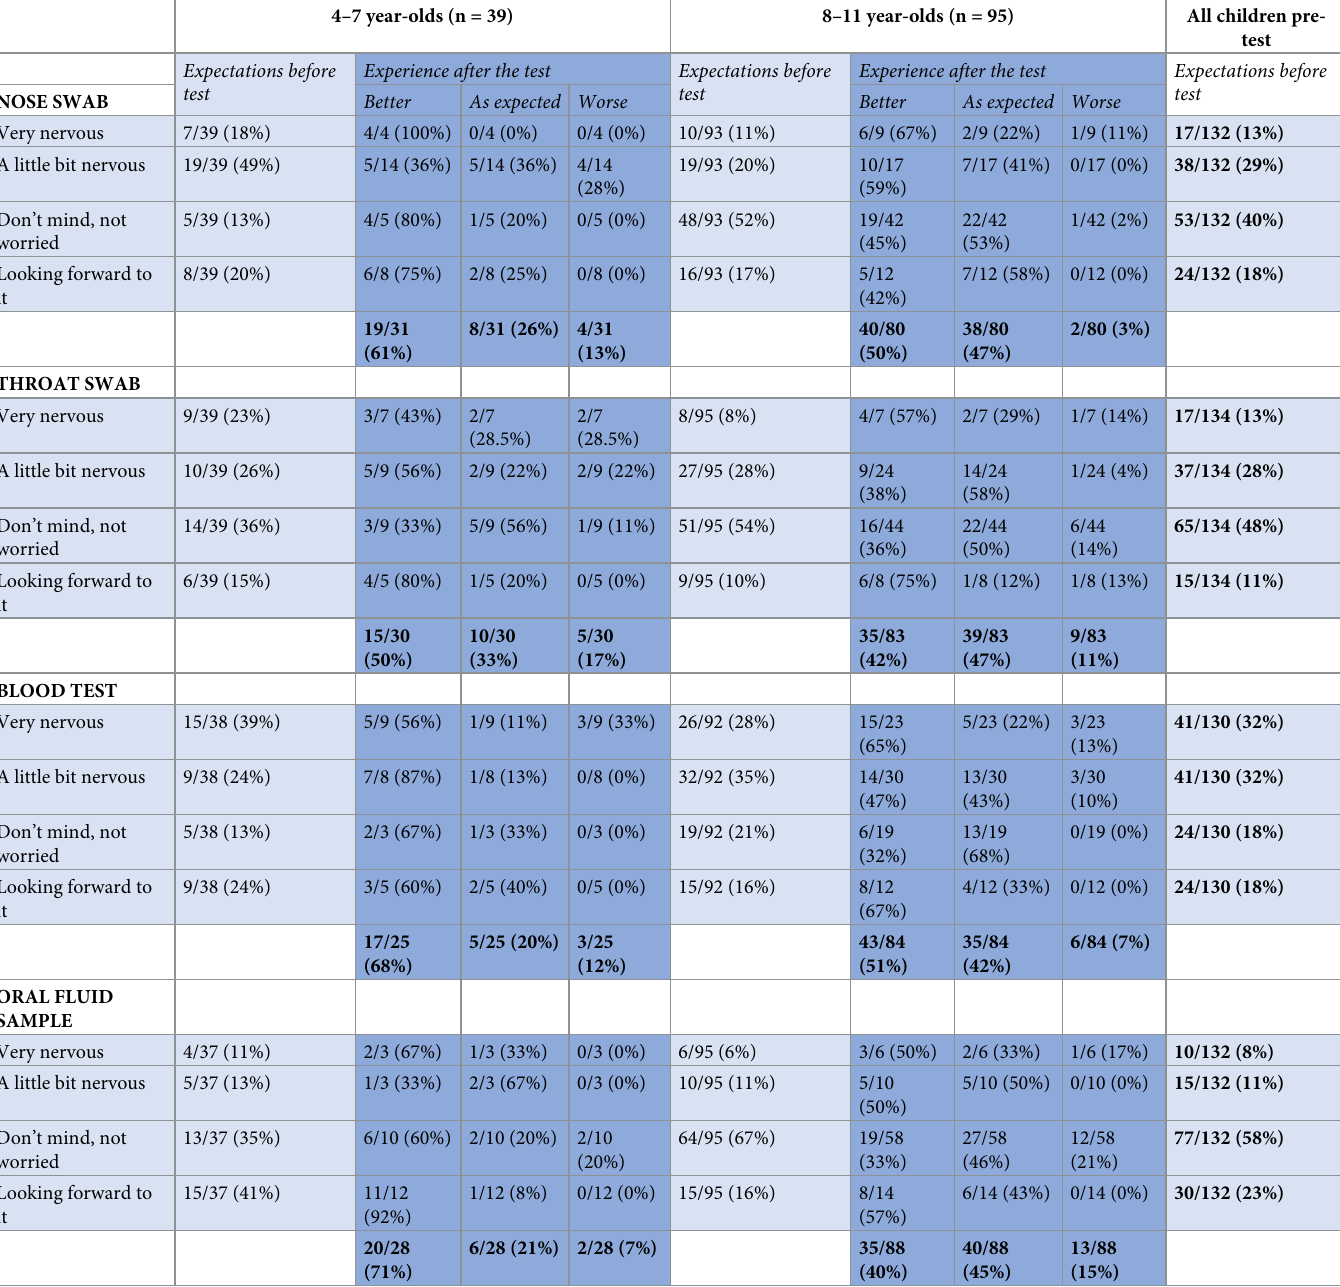
Table 1. Children’s reported expectations before the test, and experiences after the